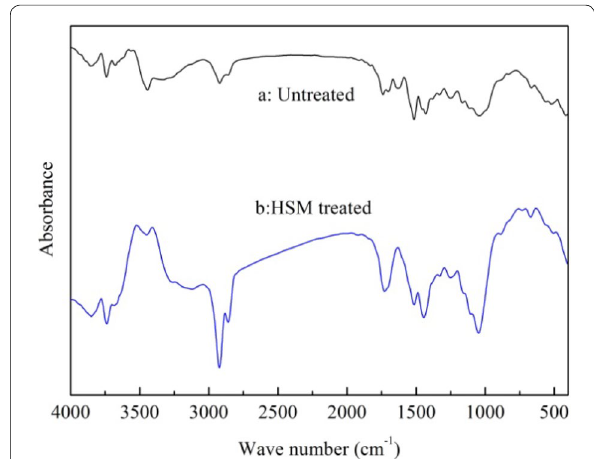
Fig. 5 FTIR curves of homogeneous sol mixture (HSM)-treated and untreated bamboo